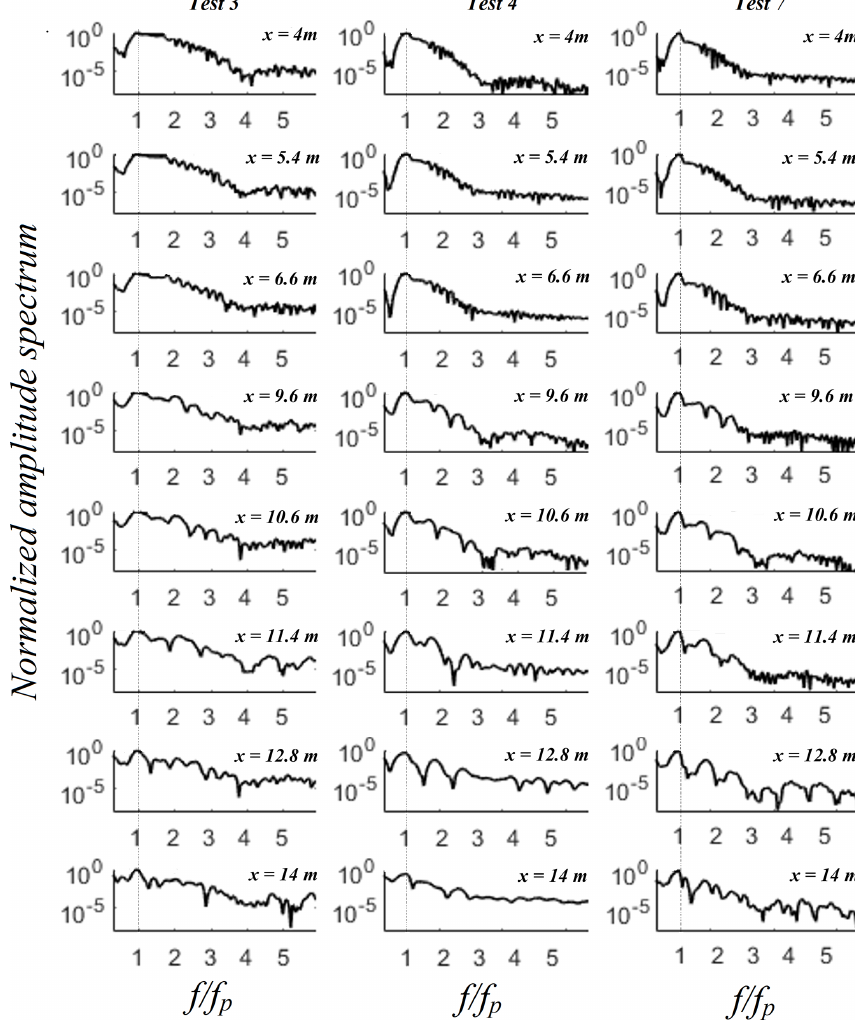
Figure 4. Spatial evolution of normalised amplitude spectra in a log scale for Test 3, 4 and